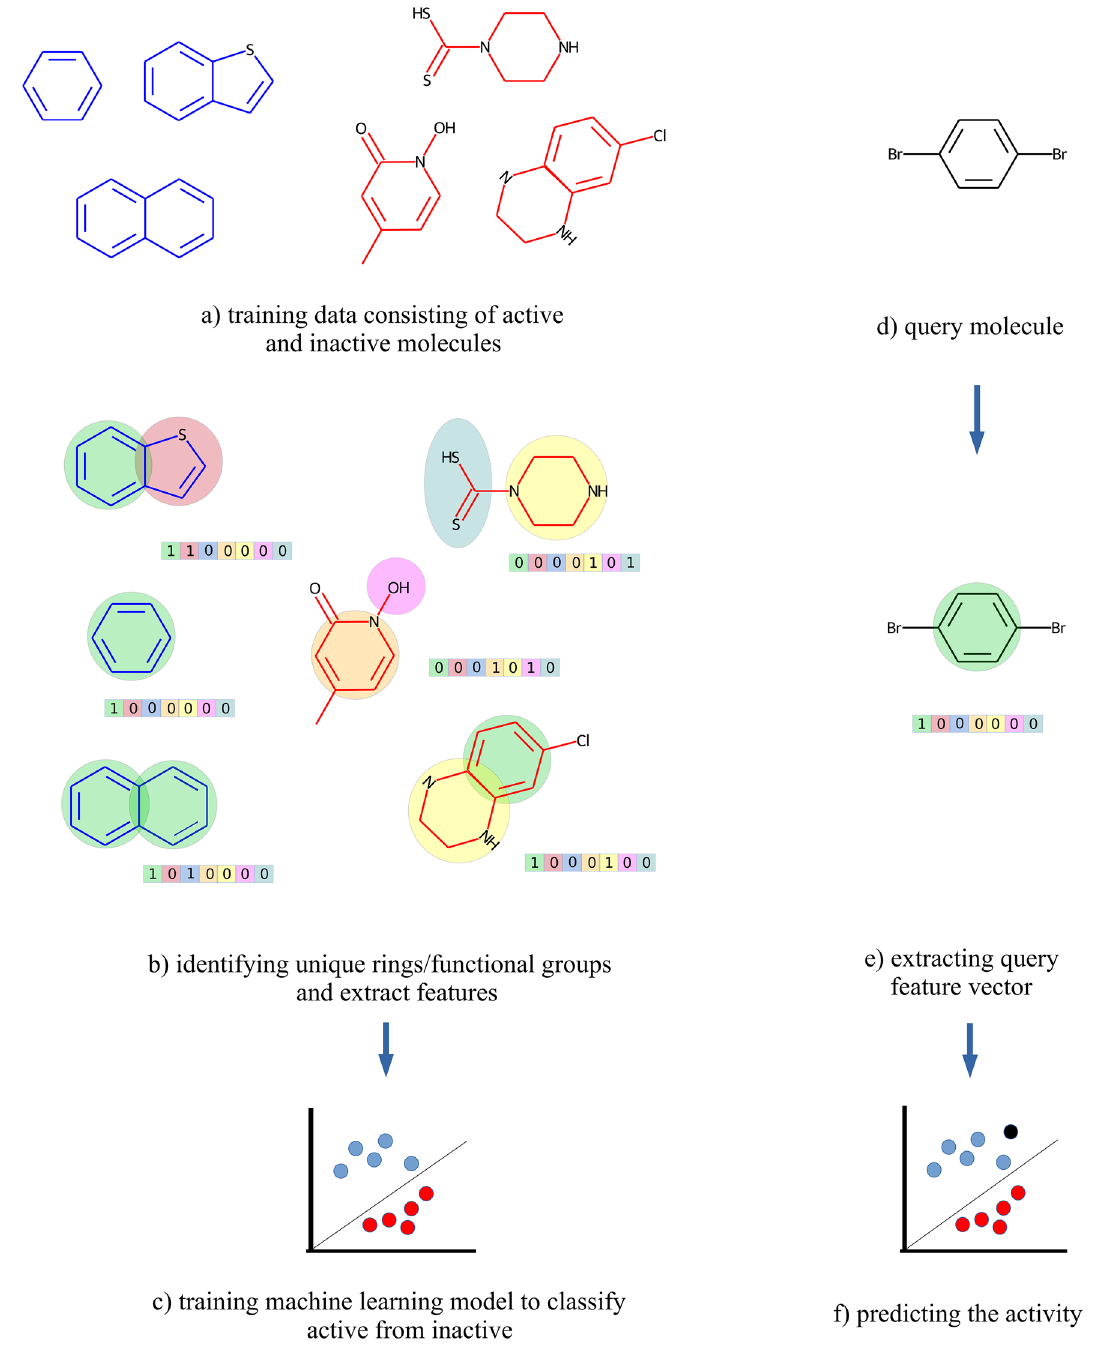
Figure 1. Interpretable prediction of antibiotic activity. Given ( a ) a collection of molecules, ( b ) InterPred finds all unique ring structures and functional groups and creates a binary vector for each molecule where zero/ one indicates absence/presence of ring structure. Then ( c ) InterPred trains a logistic regression classifier with l 1 -regularization and balanced scoring/extra trees classifier on the resulting binary features. Given ( d ) a query molecule, ( e ) InterPred extracts the binary features, and ( f ) applies the logistic regression classifier/extra trees classifier to predict the